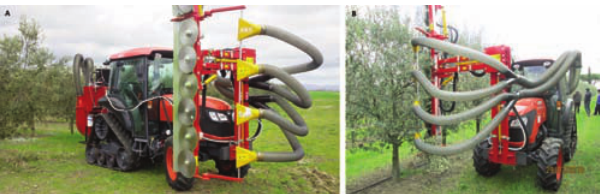
Fig. 2 - A) Cutting bar equipped with the selective pruning devi- ce; B) The pruning machine working along